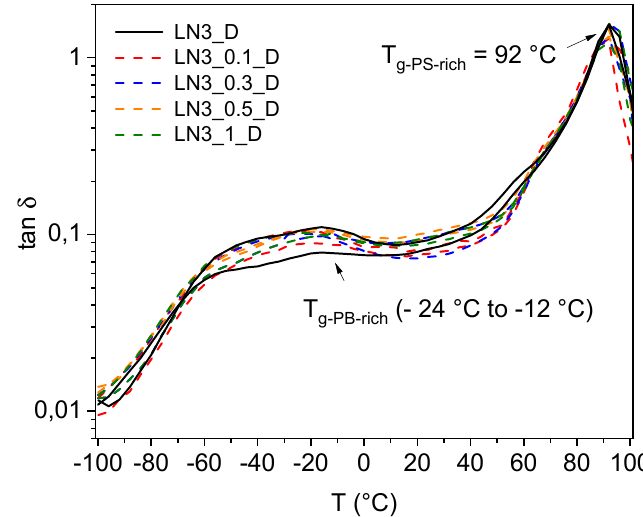
Figure 9. tan δ curves of LN3_D and its corresponding composites evaluated from DMA measurement. No significant influence of CNT addition and processing parameters on T g could be